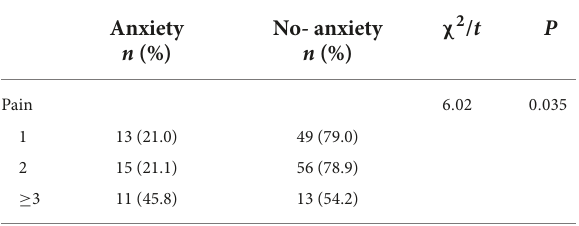
TABLE 4 Clinical related factors between anxiety and no-anxiety in MM